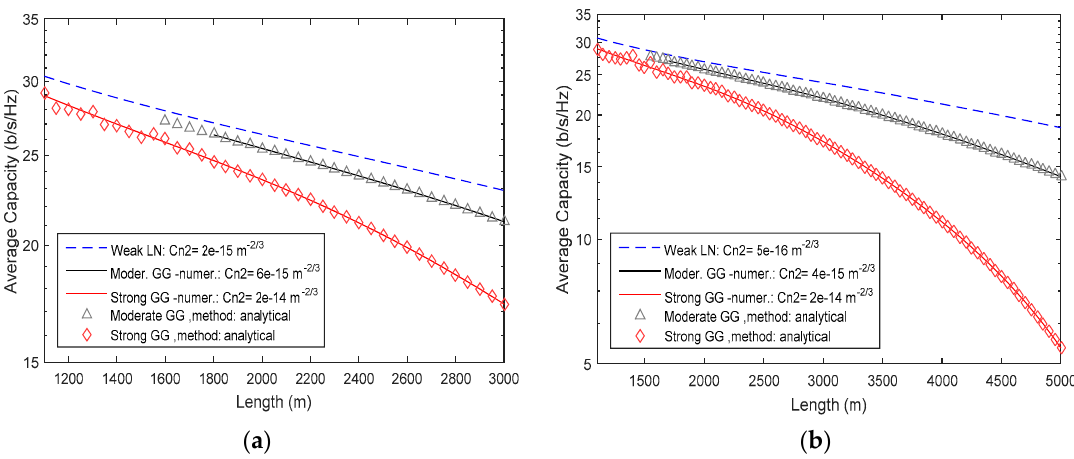
Figure 4. Average capacity performance metric for weak to strong atmospheric turbulence conditions ( a ) for links up to 3 km with receiver threshold set as − 40 dBm; ( b ) for links up to 5 km with receiver threshold set as − 30 dBm. These results use the suitable distribution model, i.e., lognormal or gamma–gamma depending on the value of the Rytov parameter, as presented in Equation (3).